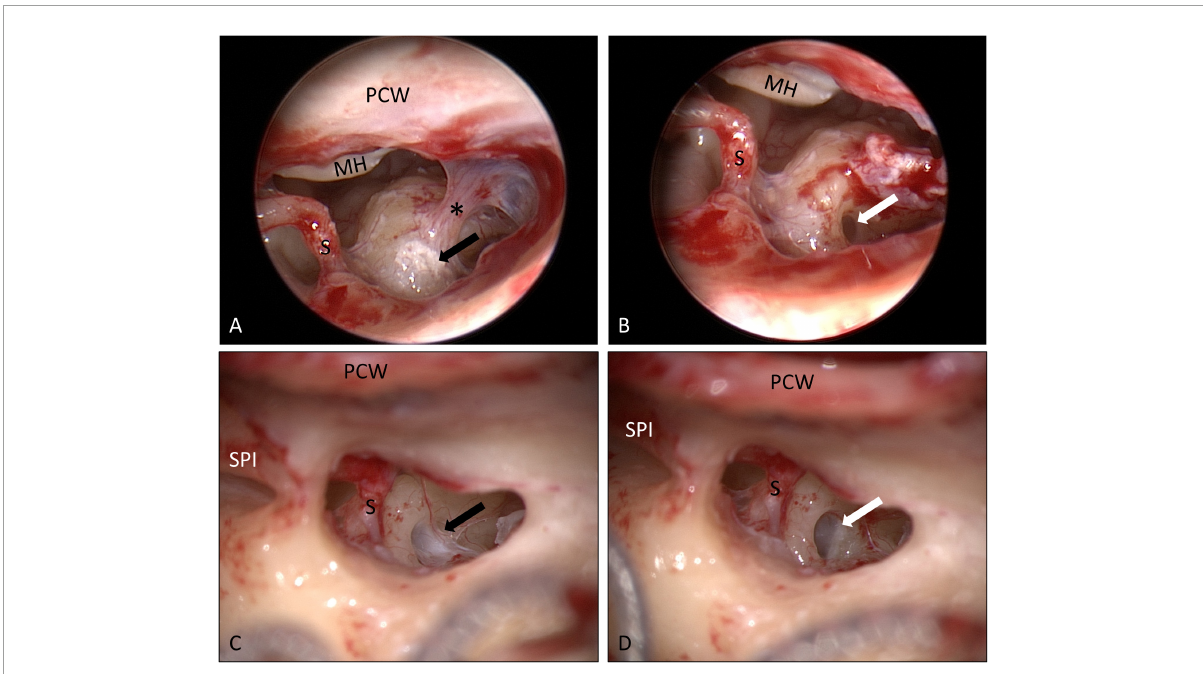
FIGURE5 Round window niche area as seen through a posterior tympanotomy at the time of cochlear implantation 18 months (A,B) and 16 months (C,D) after implantation of the biodegradable drug delivery system and sealing with soft tissue. Mild scarring ( ∗ ) between the promontory and the tympanic membrane was found ( A ) and cut. Some fibrous tissue was found in the RW niches [black arrows in panels (A,C) ] that could be removed without damaging the RWM [white arrows in panels (B,D) ]. The white material in panel (A) corresponds to calcifications. No residuals of the drug delivery implants were found (see also histology of these patients in Figures 6B,D , and immunohistochemistry in Figures 7A–C ). MH: malleus handle; PCW: posterior canal wall; S: stapes head; SPI: short process of incus. (A,B) endoscopic images, 0 ◦ , 4 mm; (C,D) microscopic